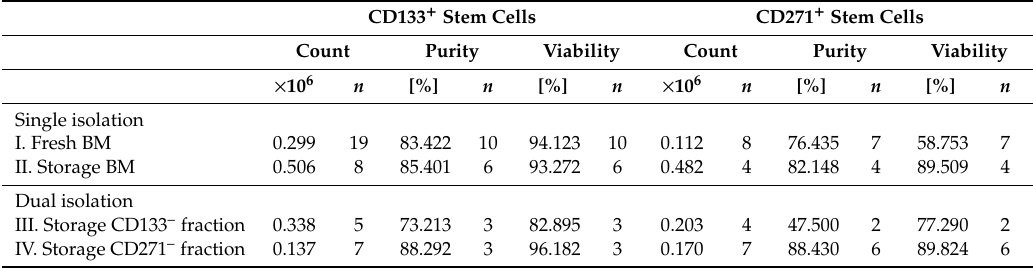
or CD271 + cells on their cell numbers and quality. Single MACS isolations of CD133 + or CD271 + cells were utilized on fresh (I) or stored (II) BM samples. For dual isolations, respective negative fractions (III or IV) were stored and respective target isolations (CD133 + or CD271 + ) were conducted after overnight storage.